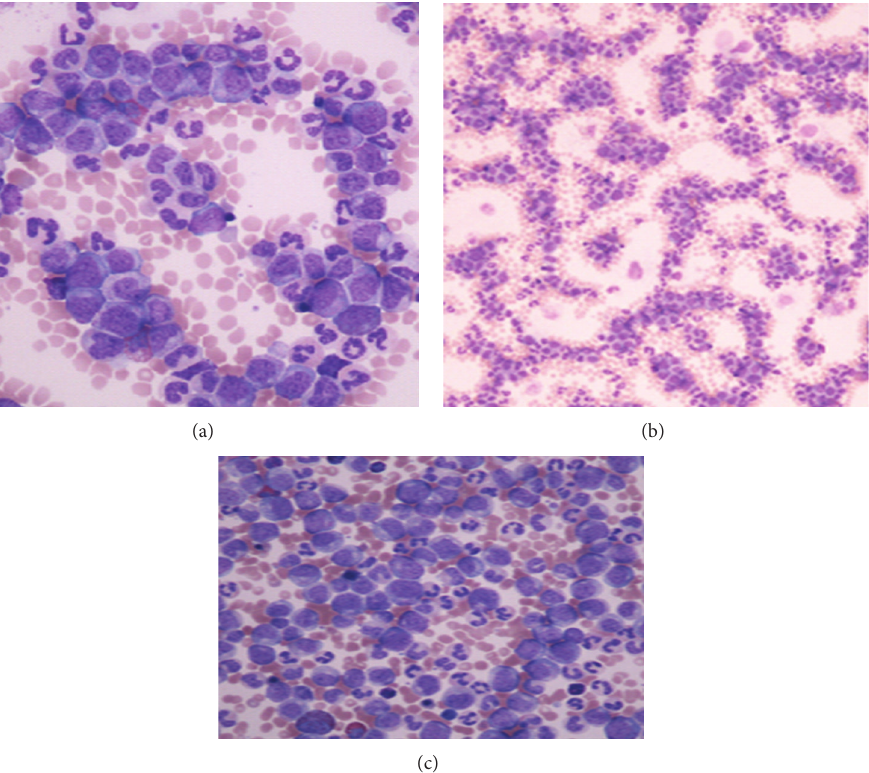
Figure 1: Peripheral smear showing marked increase in granulocyte and myeloid precursors with promyelocytes, myelocytes, metamyelo- cytes, and blast